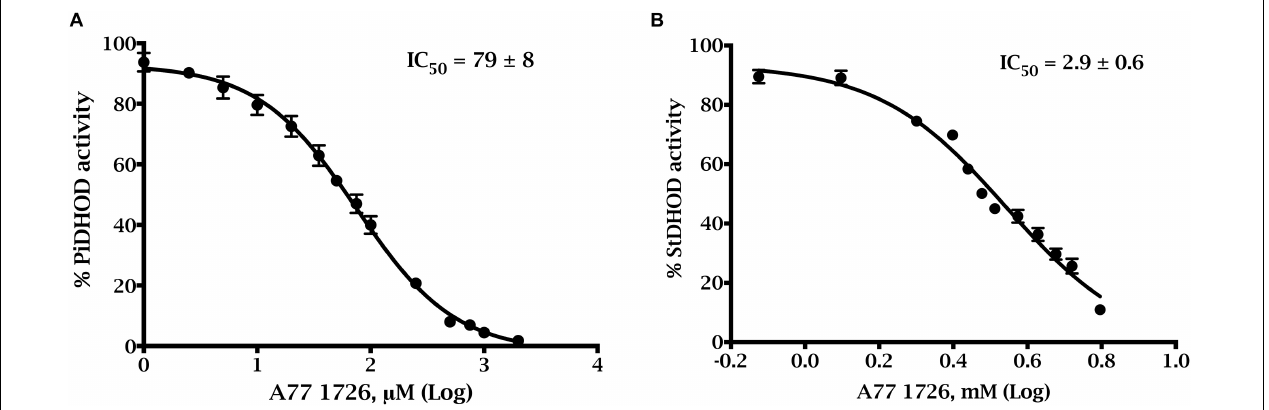
FIGURE 4 | Dose-response inhibition curves of A77 1726 for truncated recombinant P. infestans and S. tuberosum DHODHs. Activities were measured with the standard DCIP assay with saturating concentrations of Qd (0.1 mM) and dihydroorotate (1 mM), in the presence of (A) 0–2,000 µ M A77 1726 for (cid:49) N54PiDHODH, and (B) 0–5.26 mM A77 1726 for (cid:49) N69StDHODH.